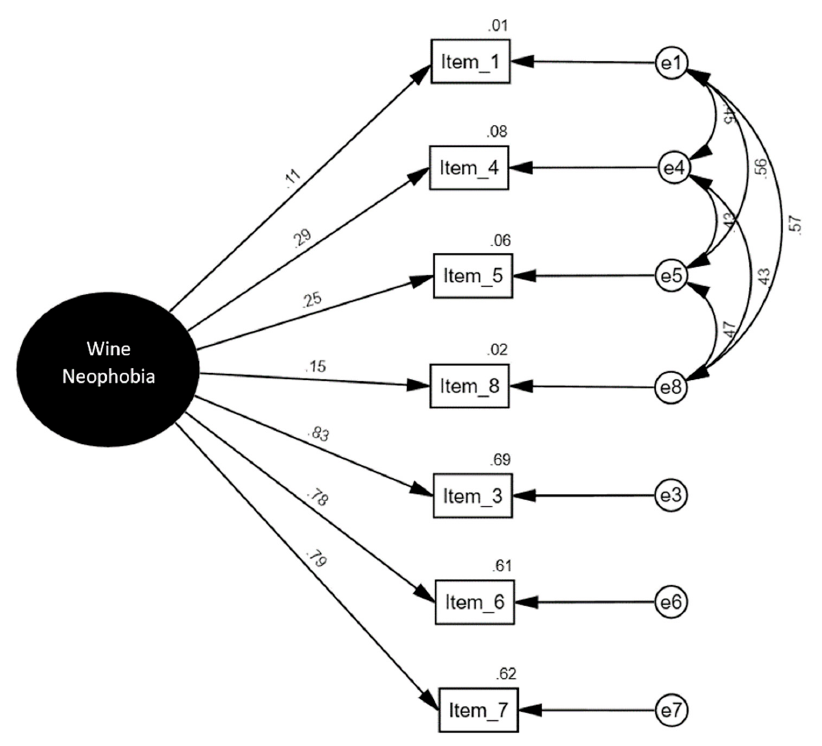
Figure A1. Best-fitting confirmatory factor analysis model, with standardized estimates, for the mWNS.